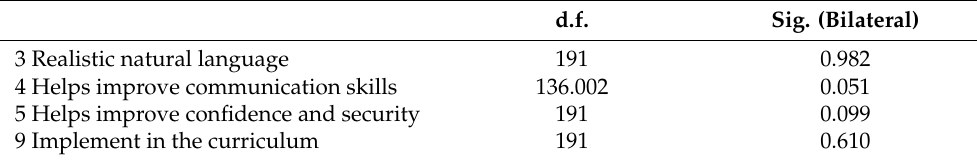
Table 7. Student’s t -test